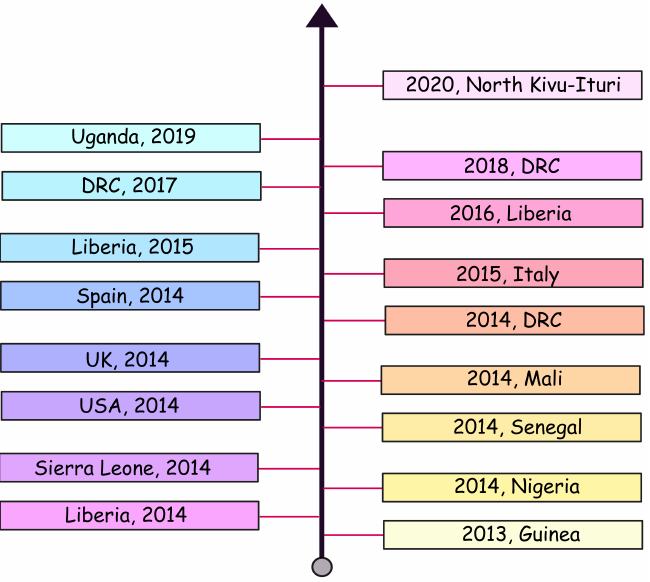
Figure 1. Timeline of the global Ebola virus epidemic between 2013 and